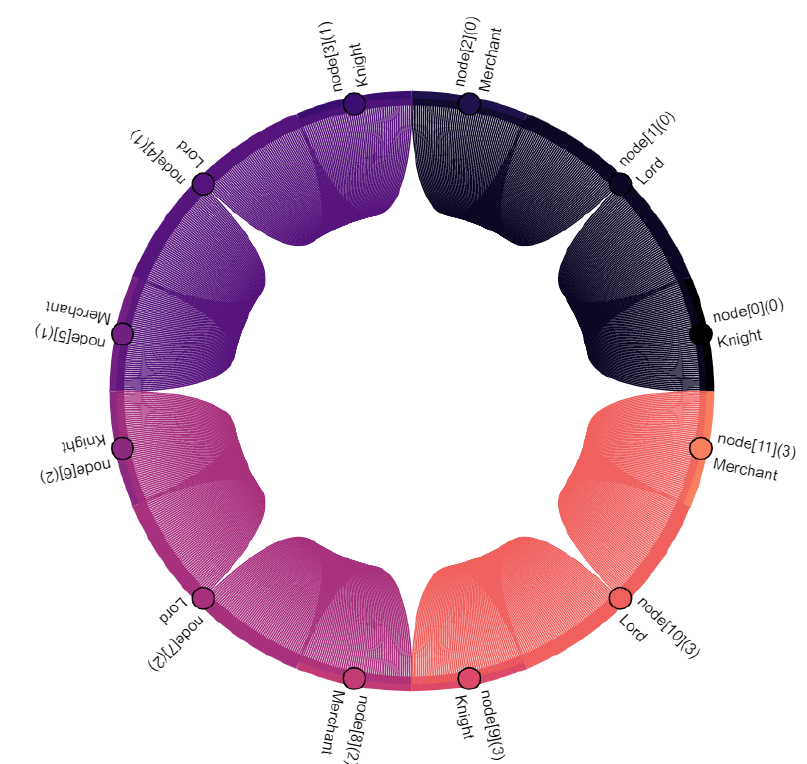
Figure 13. Lords distribute the requested data received by the server (see Figure 12) among all members of the vassalage.